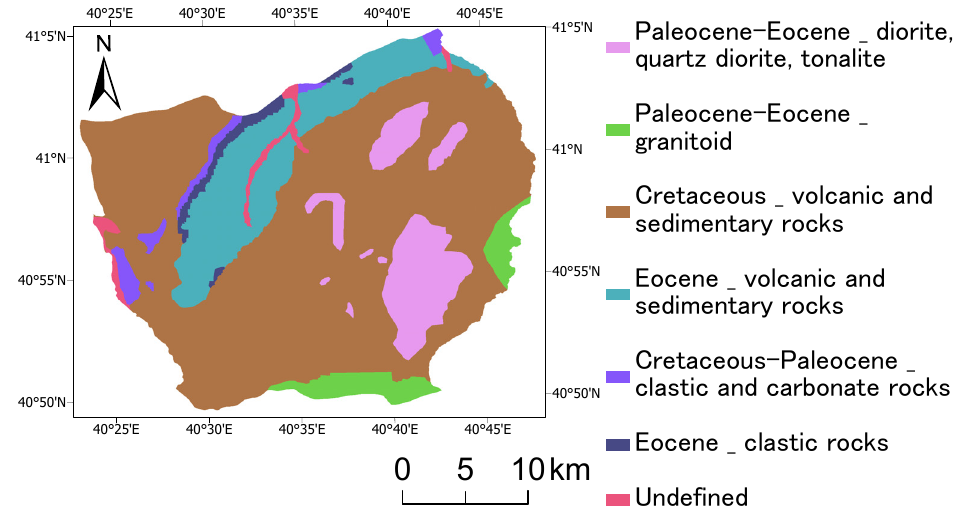
Figure 3. Geological map of the study area (adapted from Turkish General Directorate of Mineral Research and Exploration [38]).